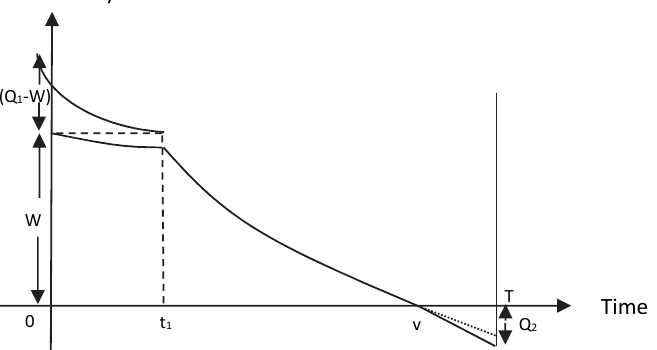
Fig. 1. Inventory time graph of two warehouse inventory